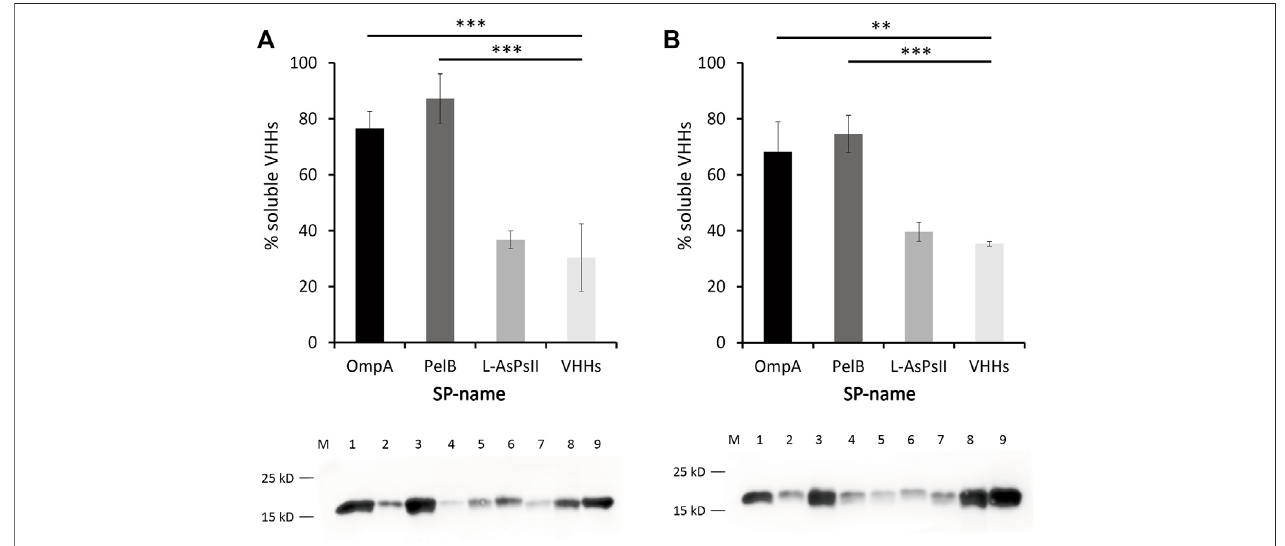
FIGURE 4 | Western blot analysis of anti-GFP VHHs with different SPs in auto-induced (A) and IPTG-induced E. coli BL21 (DE3) (B) . Percentage of soluble VHHs relativetothetotalVHHsisshown(upperpanel).Proteinswerequanti fi edbyapre-determinedpuri fi edVHHs.ImageJwasusedfortheintensityanalysis.Thesolubleand insoluble proteins were quanti fi ed according to the VHHs that have been quanti fi ed via bicinchoninic acid (BCA) assay. The sum of soluble and insoluble protein was reported as the total protein. Western blot of VHHs alone and VHHs with different SPs is shown (lower panel). M: maker, lane 1: OmpA-VHHs-S, lane 2: OmpA- VHHs-IS, lane 3: PelB-VHHs-S, lane 4: PelB-VHHs-IS, lane 5: L-AsPs II-VHHs-S, lane 6: L-AsPs II-VHHs-IS, lane 7: VHHs-S, lane 8: VHHs-IS, lane 9: puri fi ed VHHs (1.105 μ g/ μ l, positive control). S, soluble fraction; IS, insoluble fraction. Values are means ± S.D. n = 3. The signi fi cance of the differences was determined by Tukey ’ s multiple comparisons test (** p < 0.01 and *** p < 0.001).